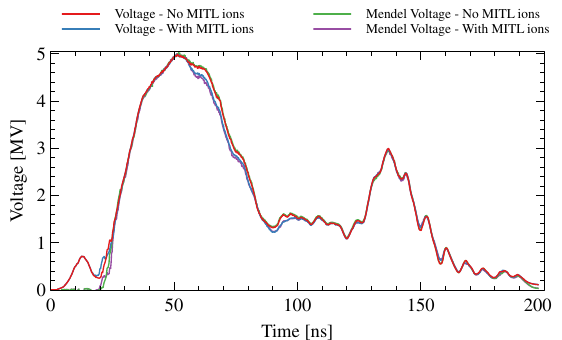
FIG. 9. Comparison of voltages from Case 0 and Case M4. The reduction in MITL line impedance due to upstream ion emission from the anode can be seen in the reduced voltage just after the pulse peak.